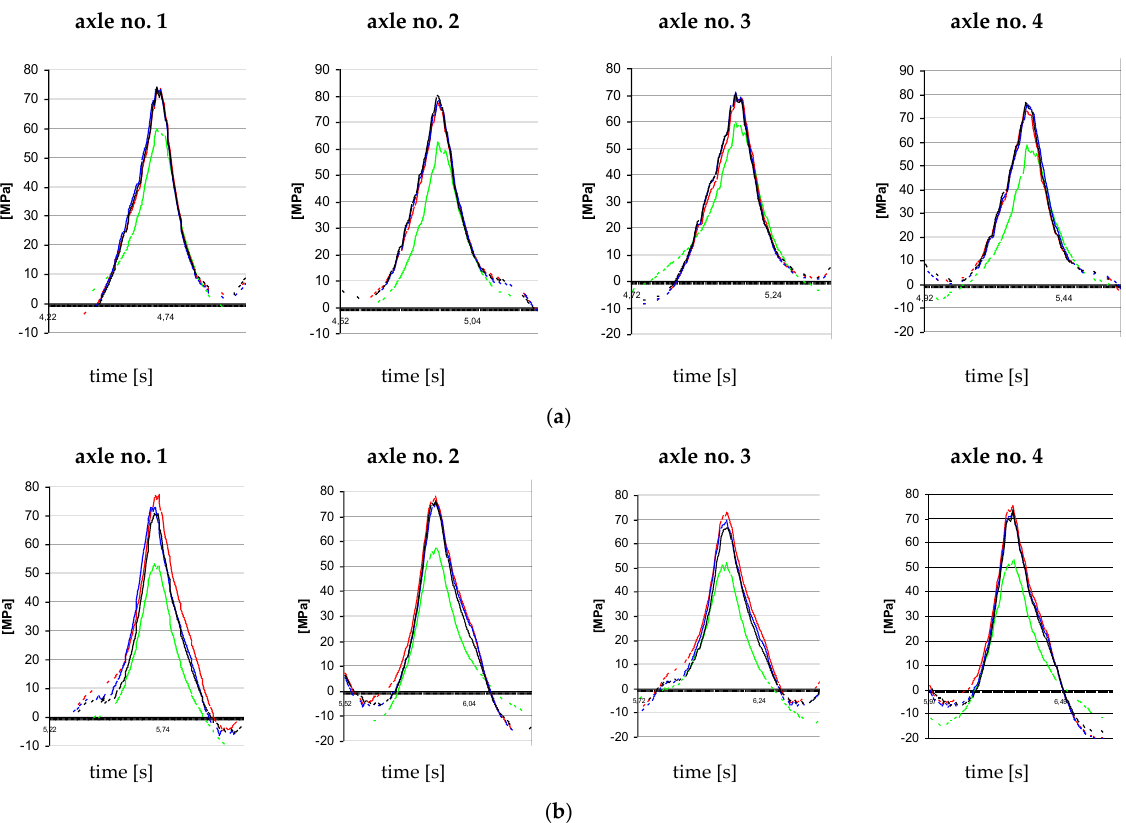
Figure 9. The rail stresses caused by induced irregularity in the railway track (the rides of locomotive’s succeeding axles): ( a ) measured by an extensometer in cross-section no. 2 (Figure 3); ( b ) measured by an extensometer in cross-section no. 1 (Figure